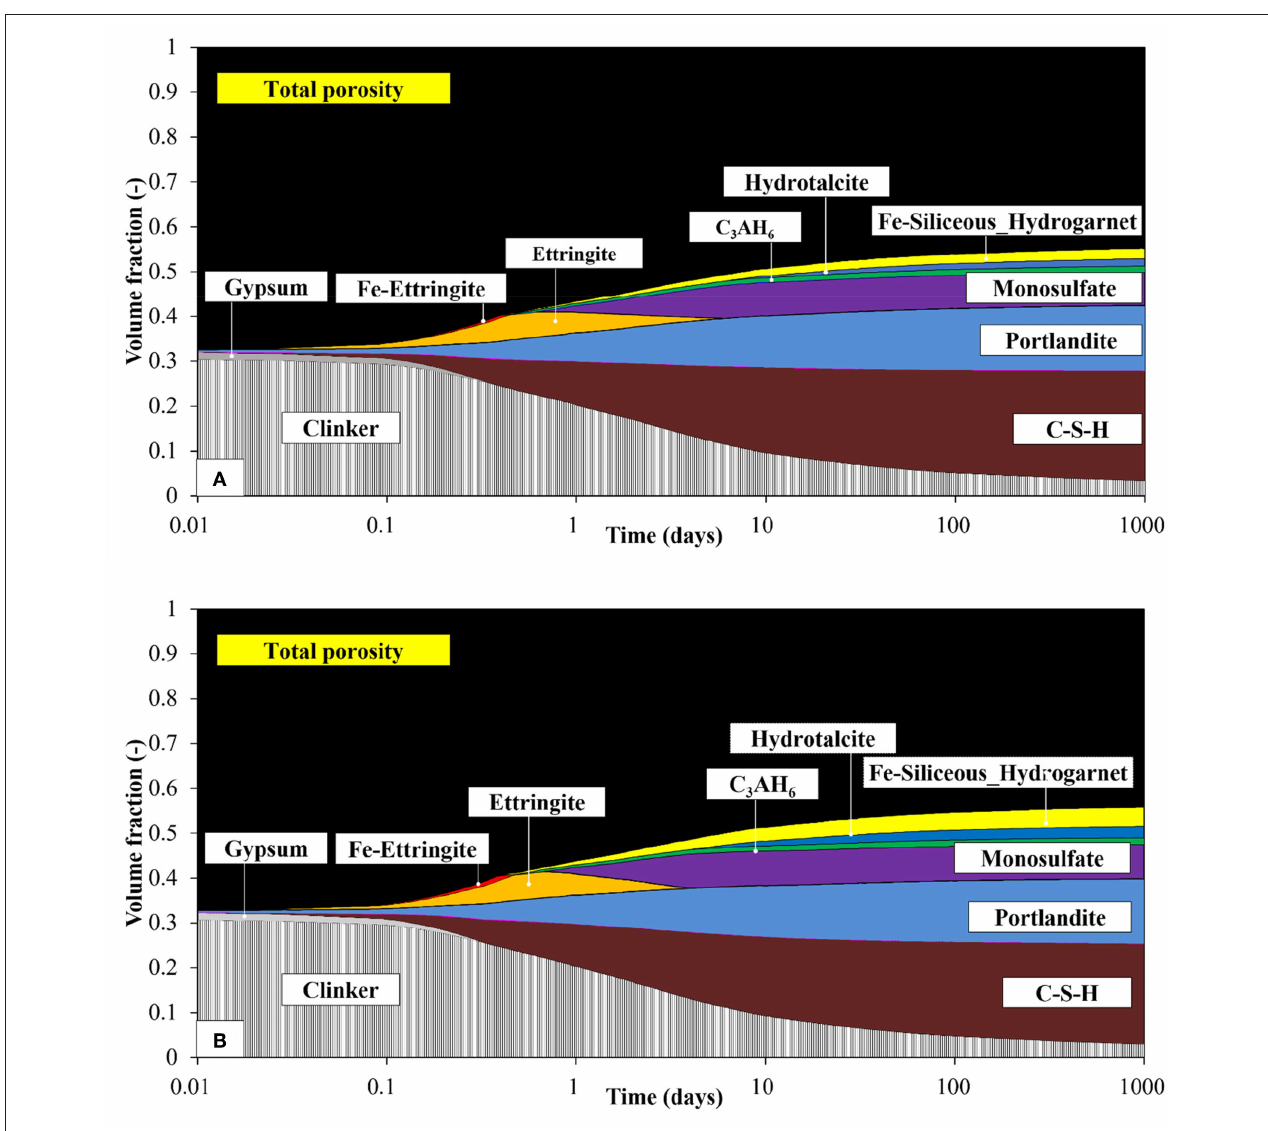
FIGURE 10 | Calculated volume of hydrates as a function of hydration time for (A) OPC and (B)